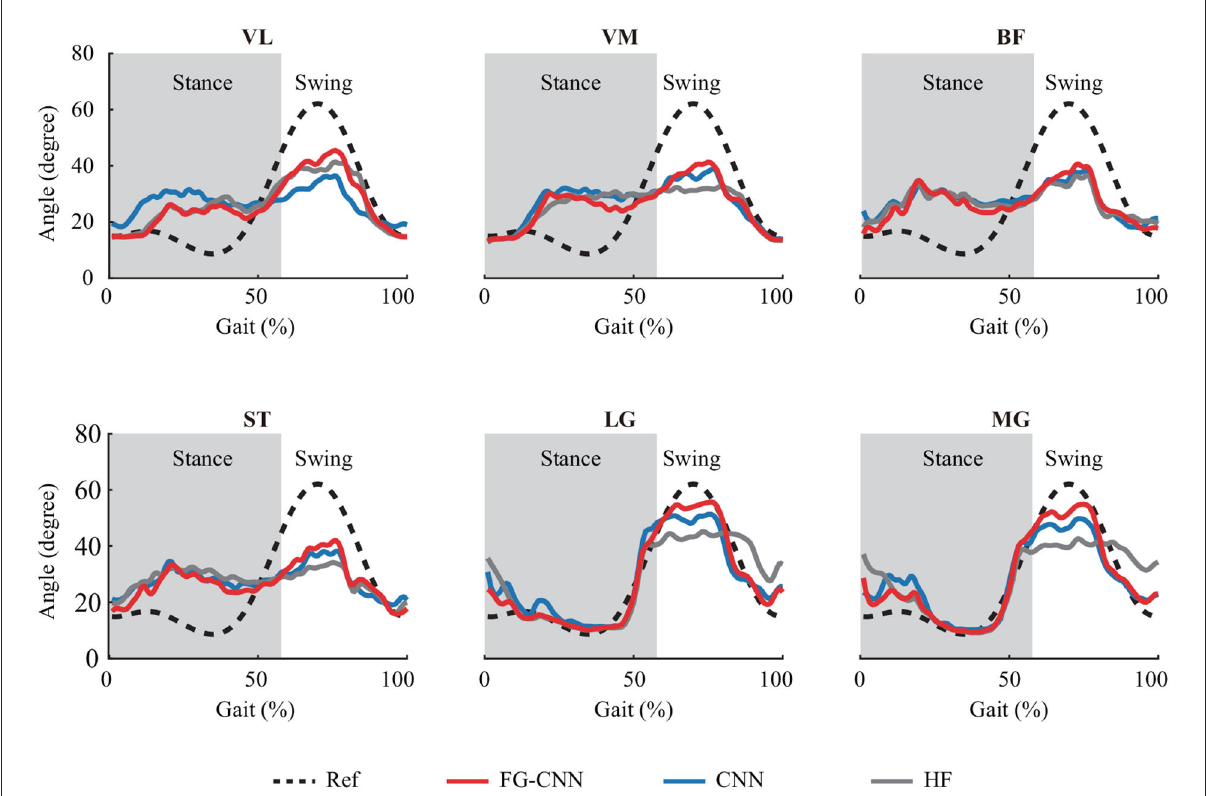
FIGURE3 Knee joint angles profiles averaged across 57 strides with subject 2. Dashed and solid lines are reference angles measured by IMUs and estimated angles by FG-CNN-RF, CNN-RF, and HF-RF, using single-channel sEMG signals. The gray shaded area indicates the stance phase.